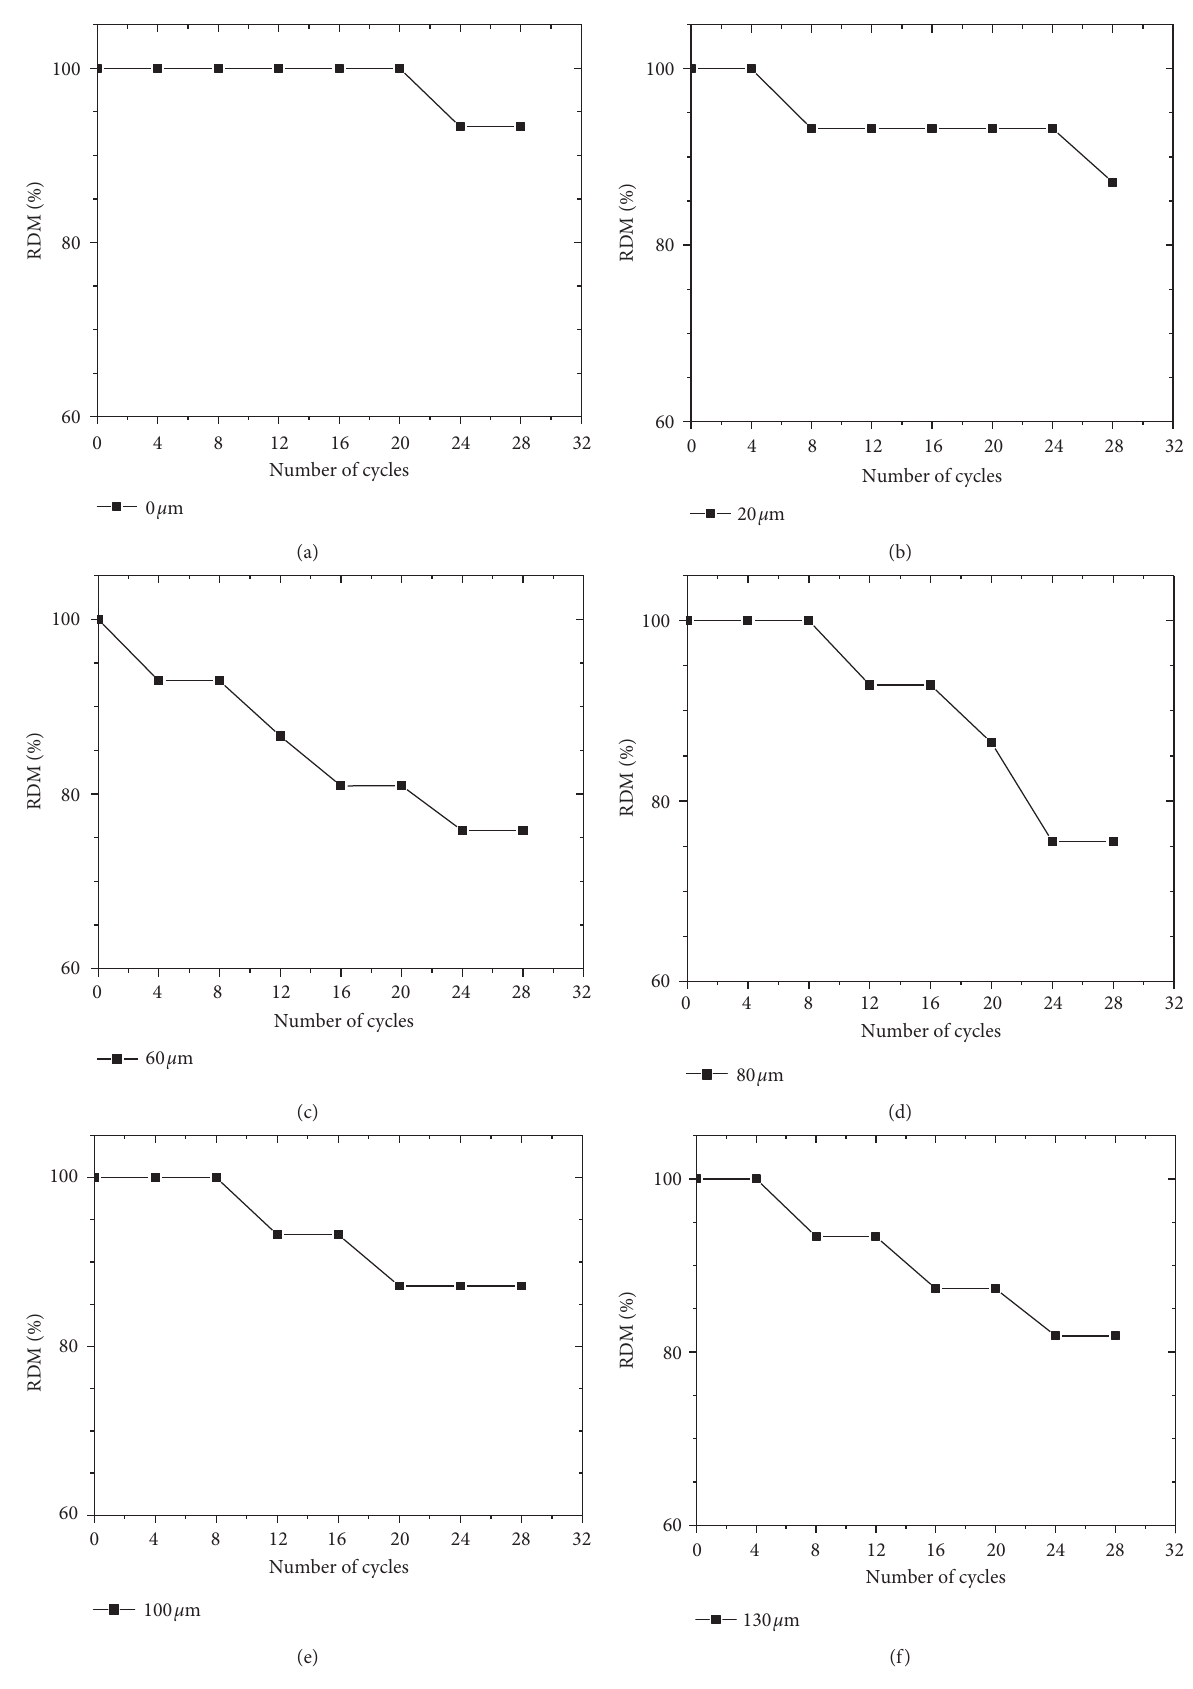
Figure 9: Changes in the relative dynamic elastic modulus of the specimens with the salt-freezing cycle: (a) 0, (b) 20, (c) 60, (d) 80, (e) 100, and (f) 130 μ